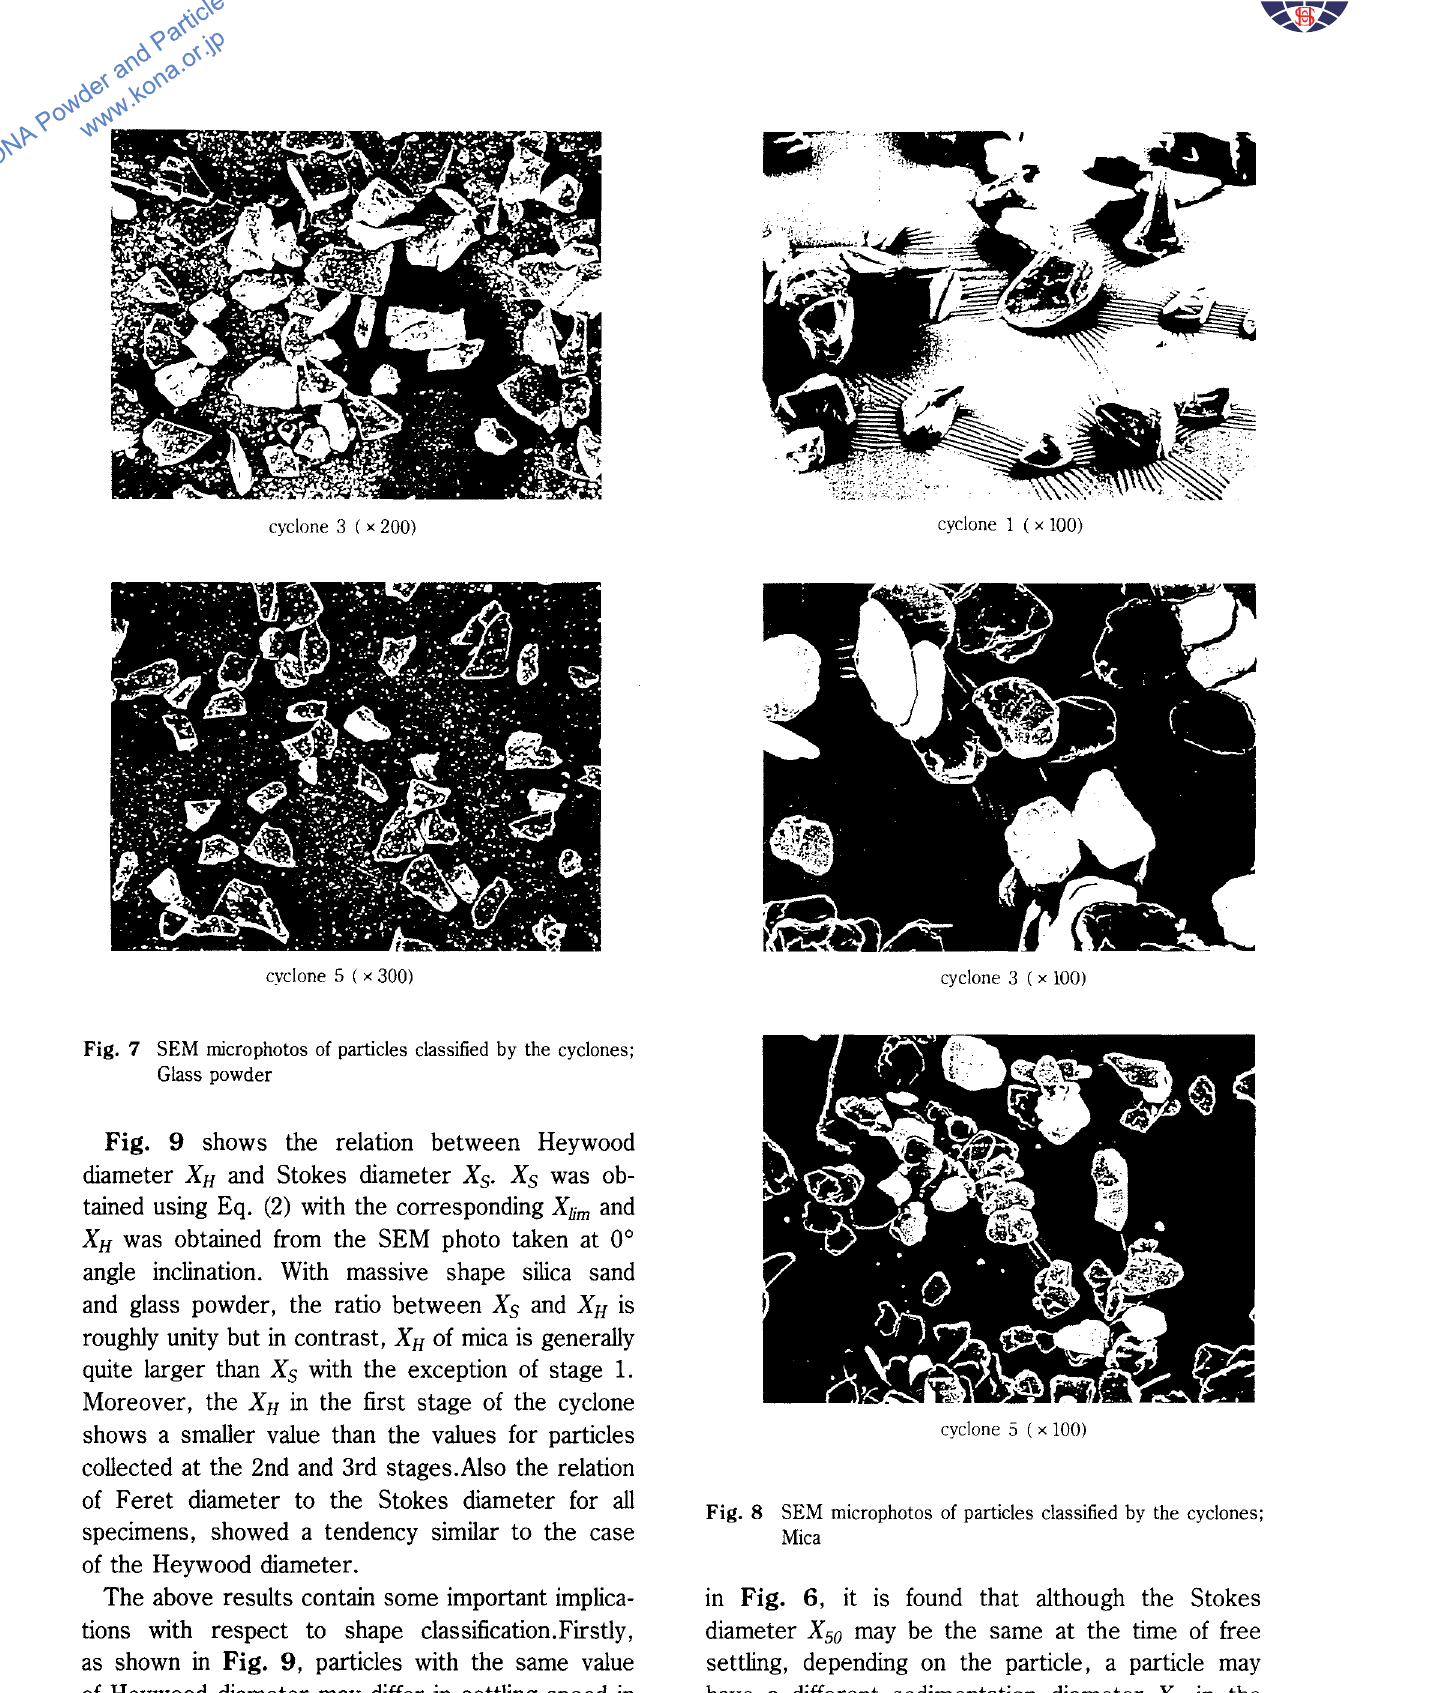
Fig. 8 SEM microphotos of particles classified by the cyclones;